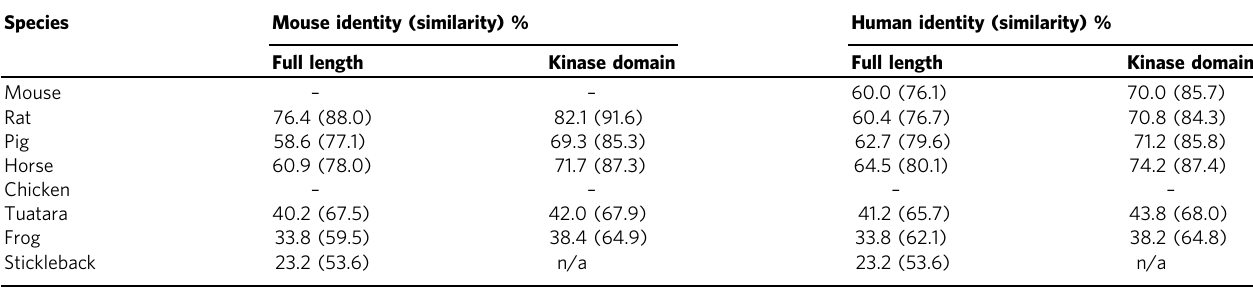
Table 2 Pairwise amino acid sequence identity and similarity of full length or kinase domains of RIPK3 orthologues. Species Mouse identity (similarity)